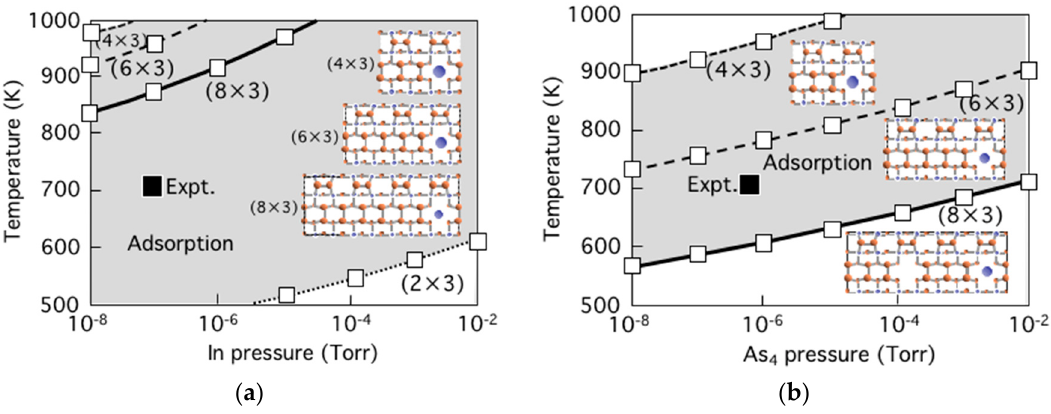
Figure 9. Calculated adsorption-desorption boundaries for ( a ) In atom and ( b ) As-dimer on the InAs(001)-( n × 3) WL surfaces as functions of temperature and BEP of In and As 4 , respectively.